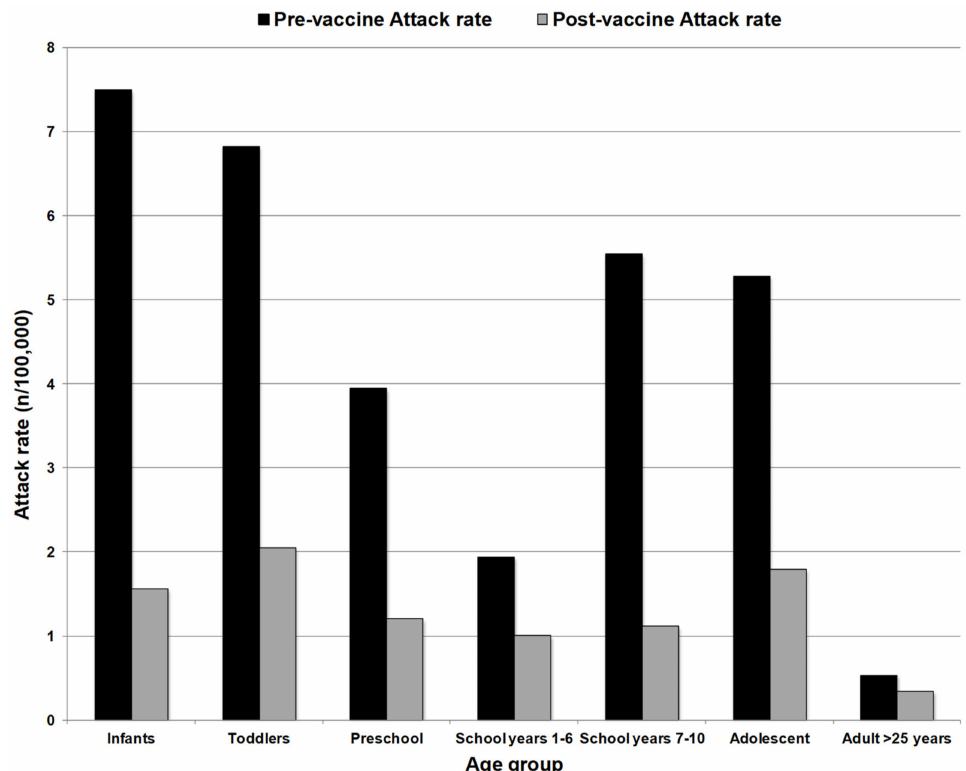
Figure 1. Group C attack rate (cases per 100,000 population) among unvaccinated people before MCC introduction (1998 / 99) and after vaccine introduction (2001 / 2002). Substantial reductions were observed across all age groups despite lack of direct protection, indicative of a herd protective e ff ect. Adapted from Ramsay et al.